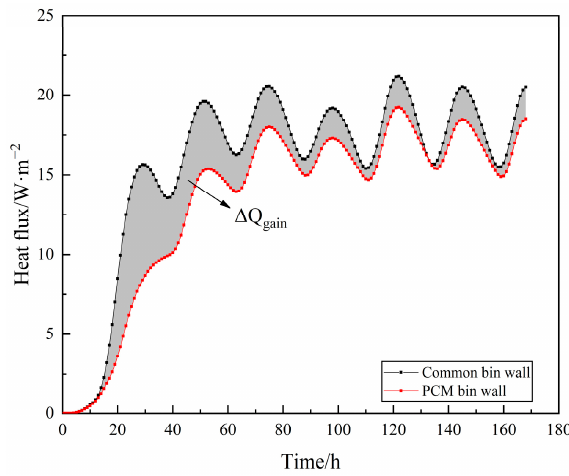
Figure 3. Weekly heat gain description of bin wall.